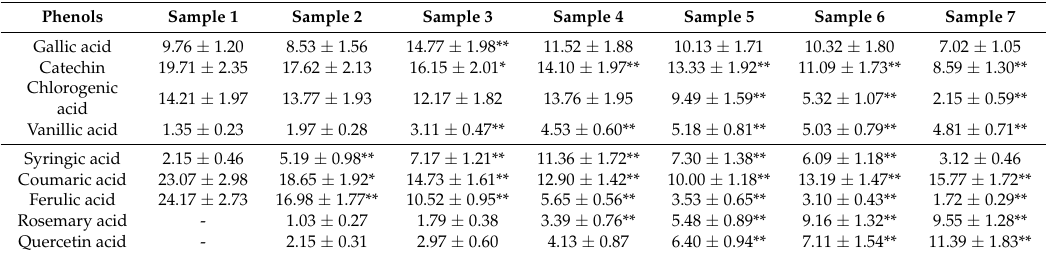
Table 3. Content of nine phenols of RSM fruits from different maturity stages (mean ± SD, mg/g, n = 3). Phenols Sample 1 Sample 2 Sample